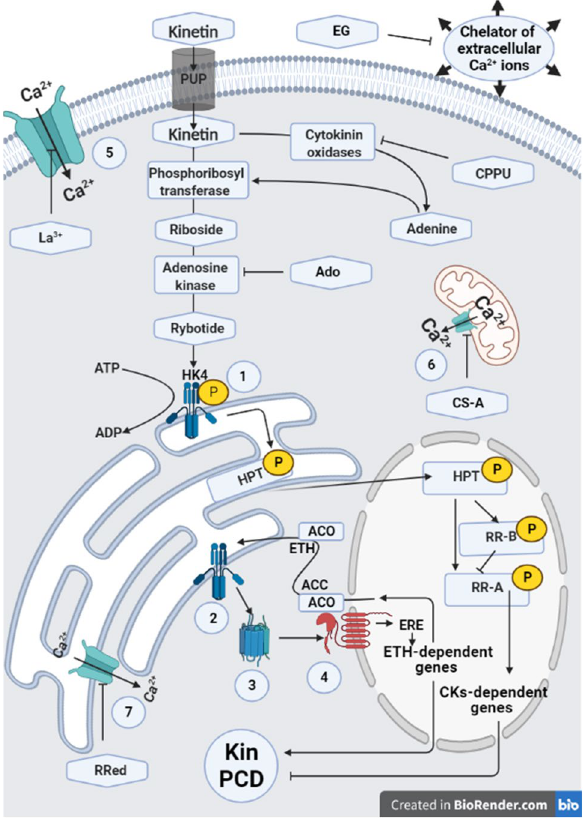
Figure 9. Schematic of the mechanism of the Kin-PCD signalling pathway based on the suggestions presented by Doniak et al. 6 and Kunikowska et al. 9 and the results described in the present study on the root cortex of Vicia faba ssp. minor seedlings. Kin transported to the cell through purine transporter (PUP) is converted to riboside and then to ribonucleotide (ribotide). The ribotide activates histidine kinase (HK) receptors (i.e., HK4),